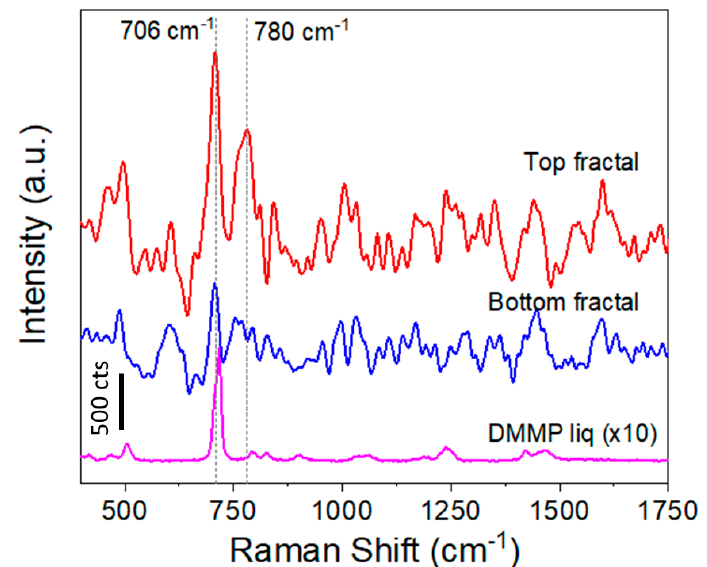
Figure 10. SERS spectra recorded on top and bottom of a 1G fractal sample (1G_Ag_AuNPs) upon exposure to 1.2 ppmV of DMMP in gas phase. A normal Raman spectrum of DMMP in liquid phase is included for comparison. Acquisition conditions: 5 mW and 1 s.